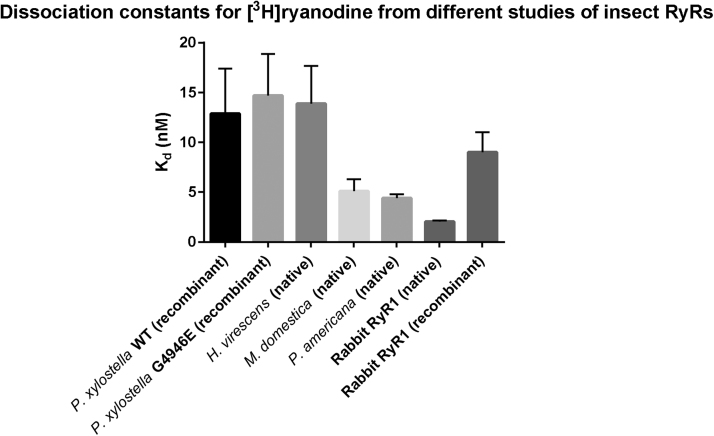
Comparison of mean dissociation constants (Kd) between the WT and mutant P. xylostella RyR (Troczka et al., 2015a) and other insects and rabbit RyR1 reported in literature (Ebbinghaus-Kintscher et al., 2006, Lehmberg and Casida, 1994). The recombinant rabbit RyR1 was expressed in Sf21 cells, the only mammalian channel functionally expressed in insect cell lines (Antaramian et al., 2001).